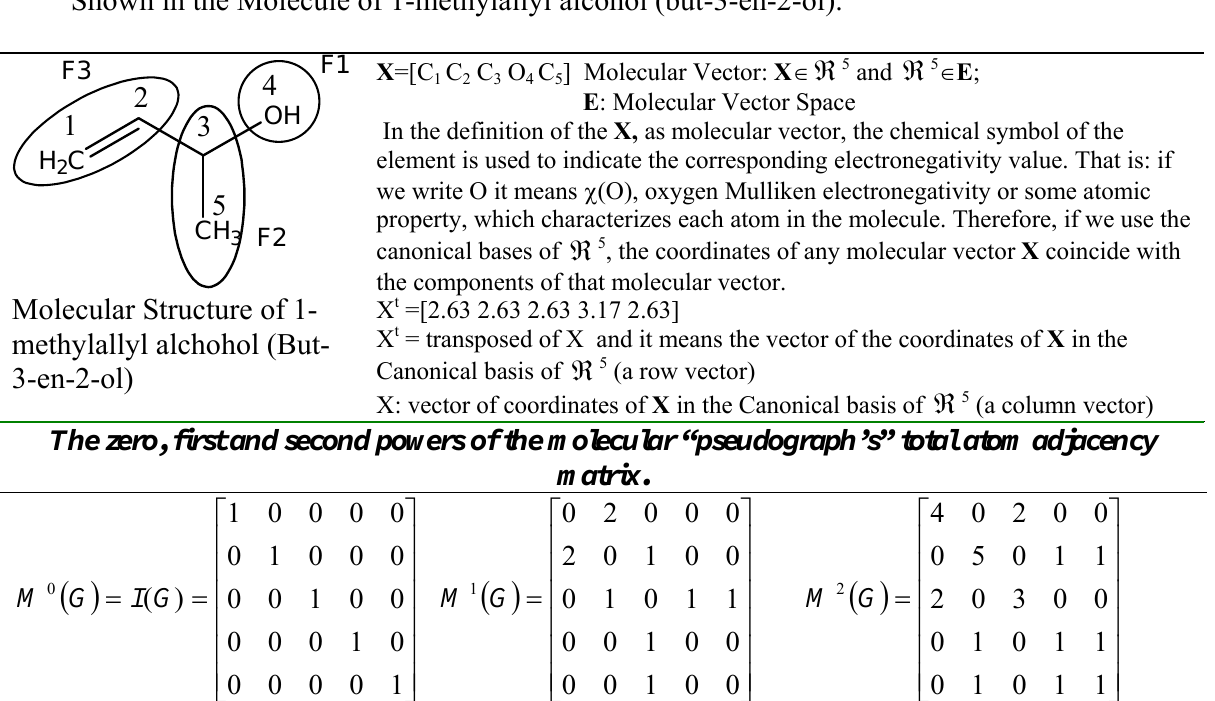
Table 3. The Zero, First and Second Powers of the Molecular (cid:147)pseudograph(cid:146)s(cid:148) Atom Adjacency Matrix and Local Matrices for These Order of Each One of 3 Fragments Shown in the Molecule of 1-methylallyl alcohol (but-3-en-2-ol).